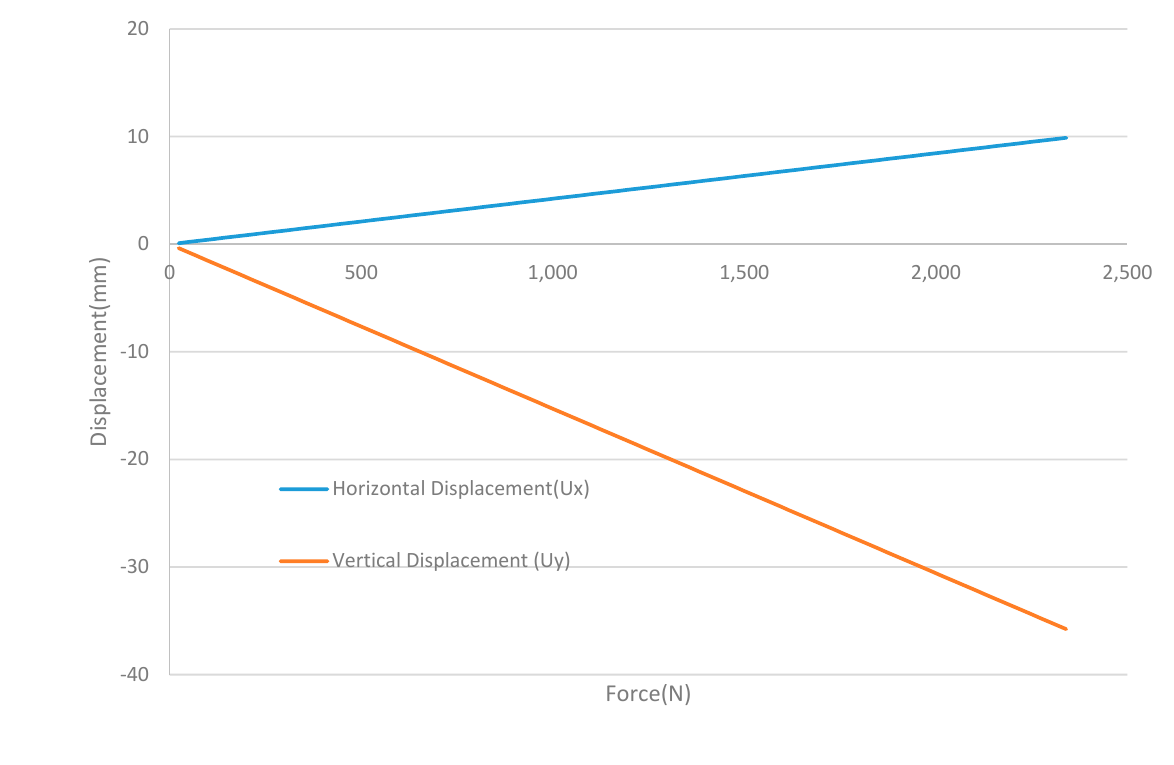
Figure 21. Horizontal and vertical displacements at node 20, element 1126 with coordinate details: ( x = 0, y = 0.25, z = − 4) and 30% FA.